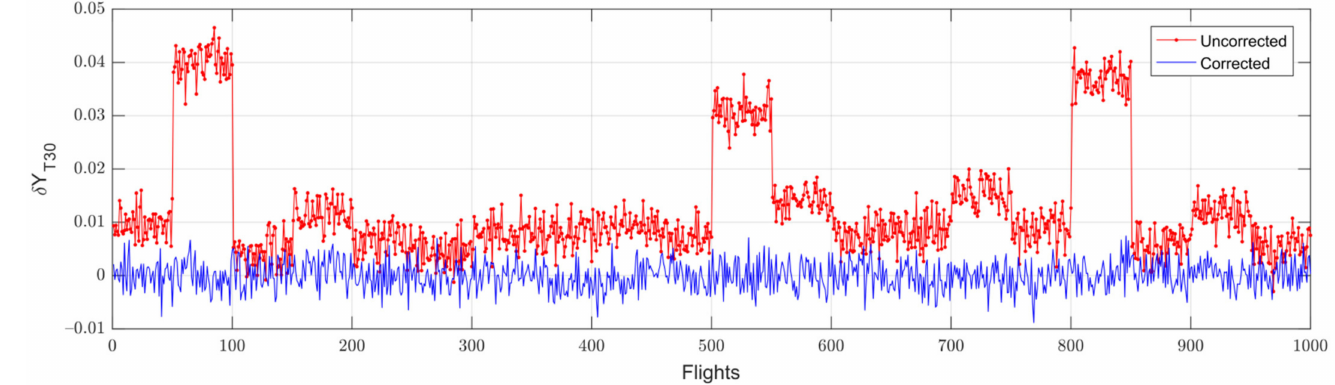
Figure 3. Corrected and uncorrected deviations for different healthy